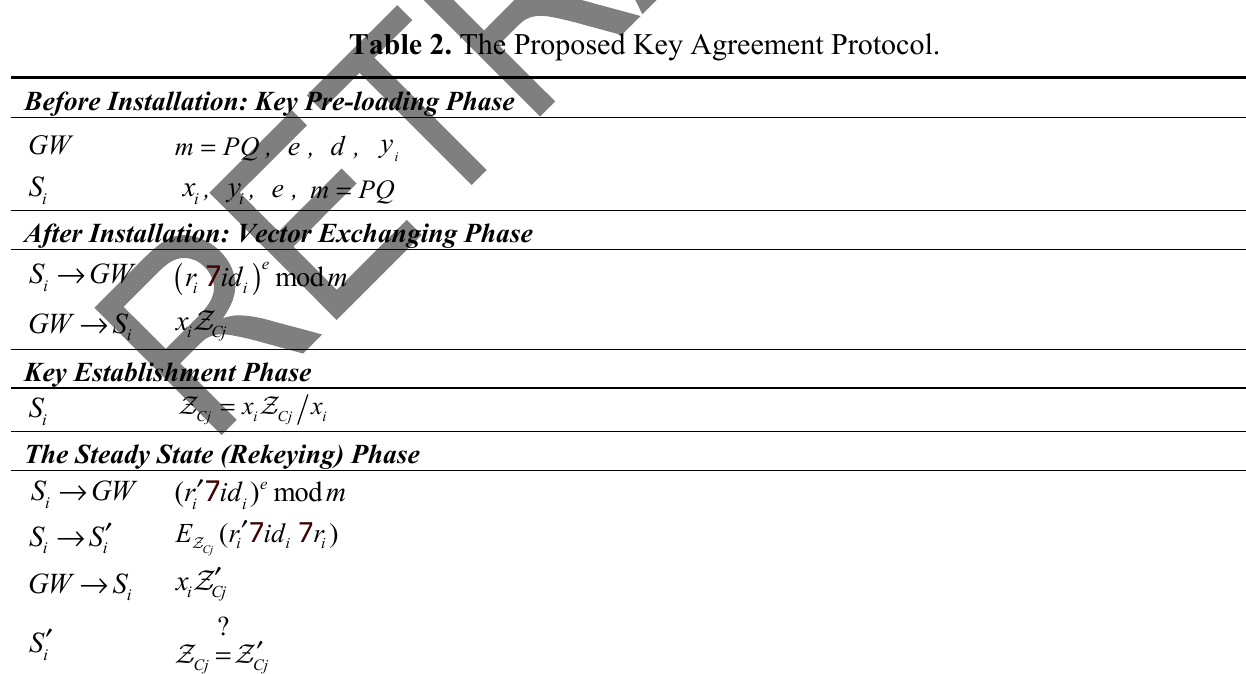
Table 2. The Proposed Key Agreement